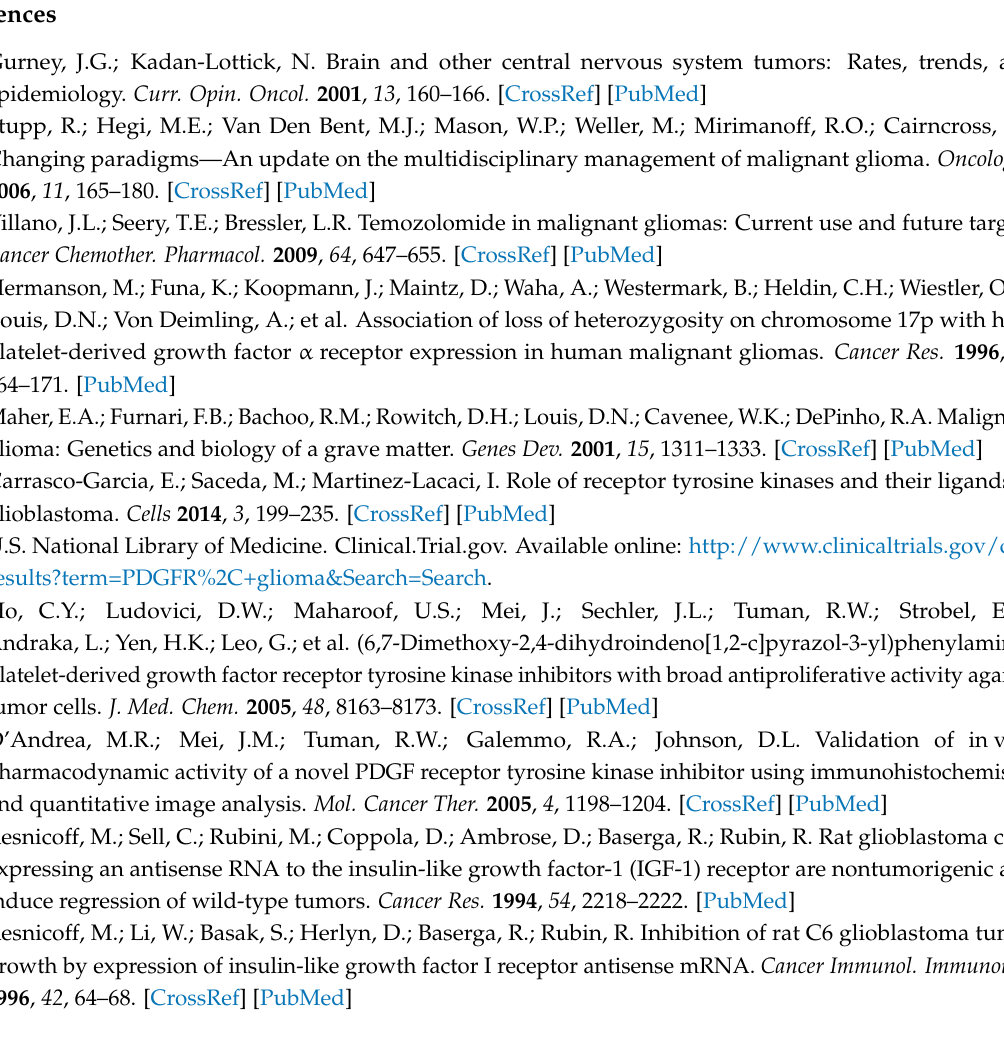
Figure S1: PPP effect on chromatin integrity, Figure S2: Caspase-independent